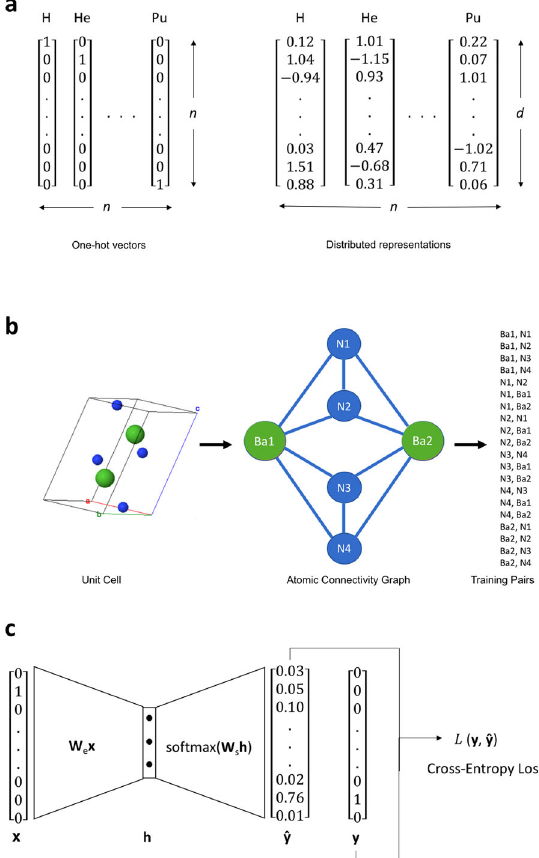
Fig. 1 Atom vectors and training process for SkipAtom. a Scheme illustrating one-hot and distributed representations of atoms. In the diagram, there are n atoms represented, and d is the adjustable number of dimensions of the distributed representation. Note that the atoms in this example are H, He and Pu, but they could be any atom. b Scheme describing how training data is derived for the creation of SkipAtom vectors. Here, a graph representing the atomic connectivity in the structure of Ba 2 N 4 is depicted, and the resulting target-context atom pairs derived for training. The graph is derived from the unit cell of Ba 2 N 4 . c Scheme describing how the SkipAtom vectors are derived through training. Here, a one-hot vector, x , representing a particular atom is transformed into an intermediate vector h via multiplication with matrix W e . The matrix W e is the embedding matrix, whose columns will be the fi nal atom vectors after training. Training consists of minimizing the cross-entropy loss between the output vector ^ y and the one-hot vector representing the context atom, y . The output ^ y is obtained by applying the softmax function to the product W s h